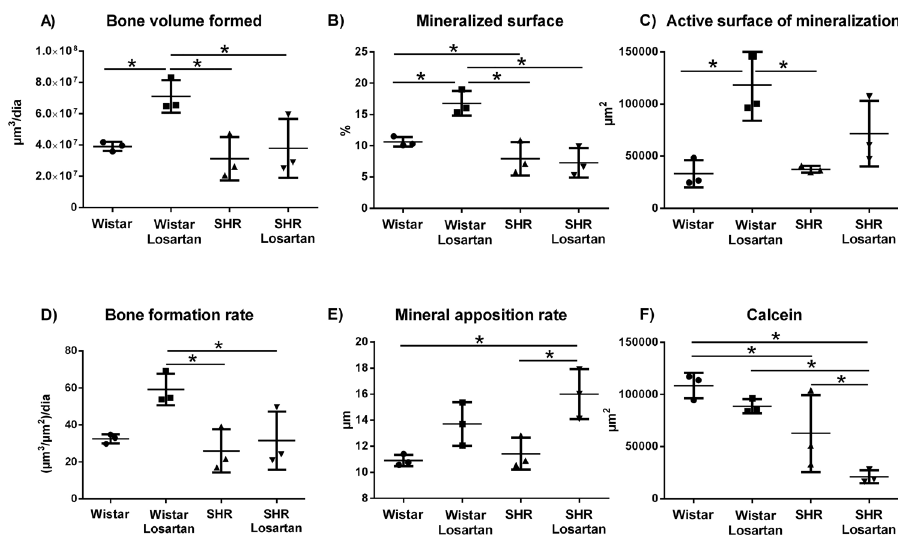
Figure 4- Parameters of laser confocal microscopy. Scatter-plots graphs with the confocal microscopy parameters evaluated in the alveolar bone of the maxilla. Data were obtained on 80 μm slides of the alveolar bone adjacent to the apical third of the right incisor. It was quantified: Calcein Fluorochromes, Active Mineralization Surface, Mineral apposition rate (MAR), Bone volume formed, Mineralized surface, and Bone formation rate. The * indicates significant statistical difference (p<0.05)